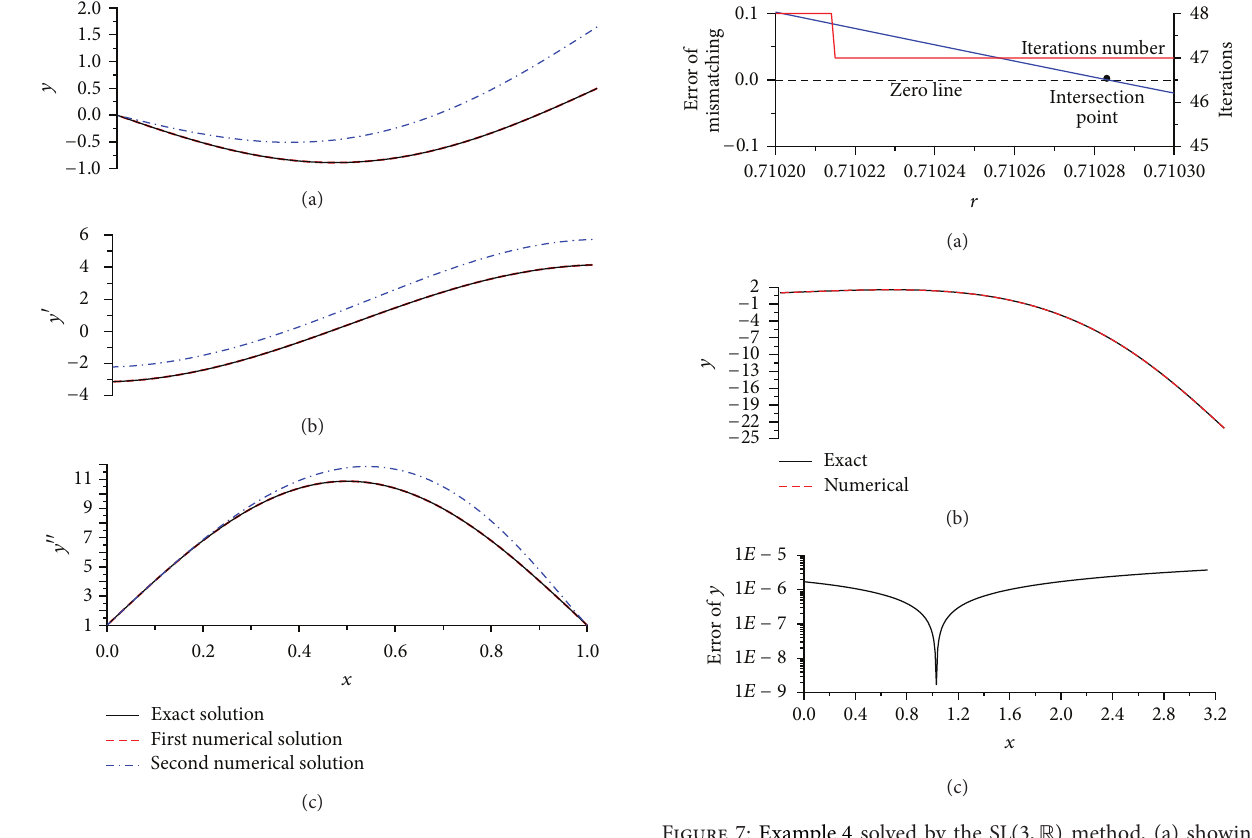
Figure 6: Example 3 comparing the first numerical solution and the second numerical solution with the exact solution.